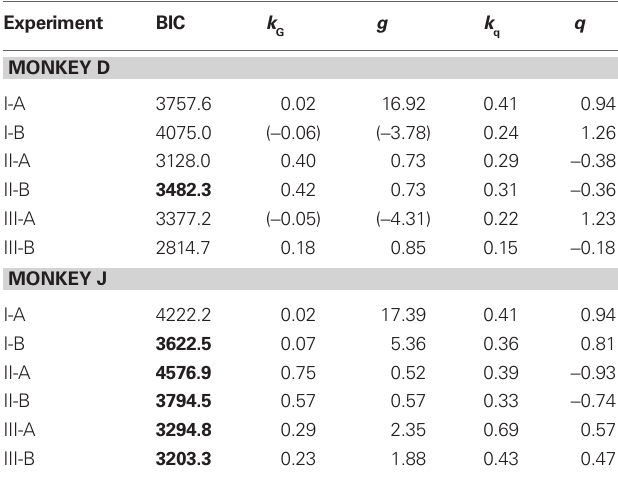
The values in the parentheses were estimated indirectly from the q-exponential discount function. The bold typeface indicates that the data were best fi t by this model.